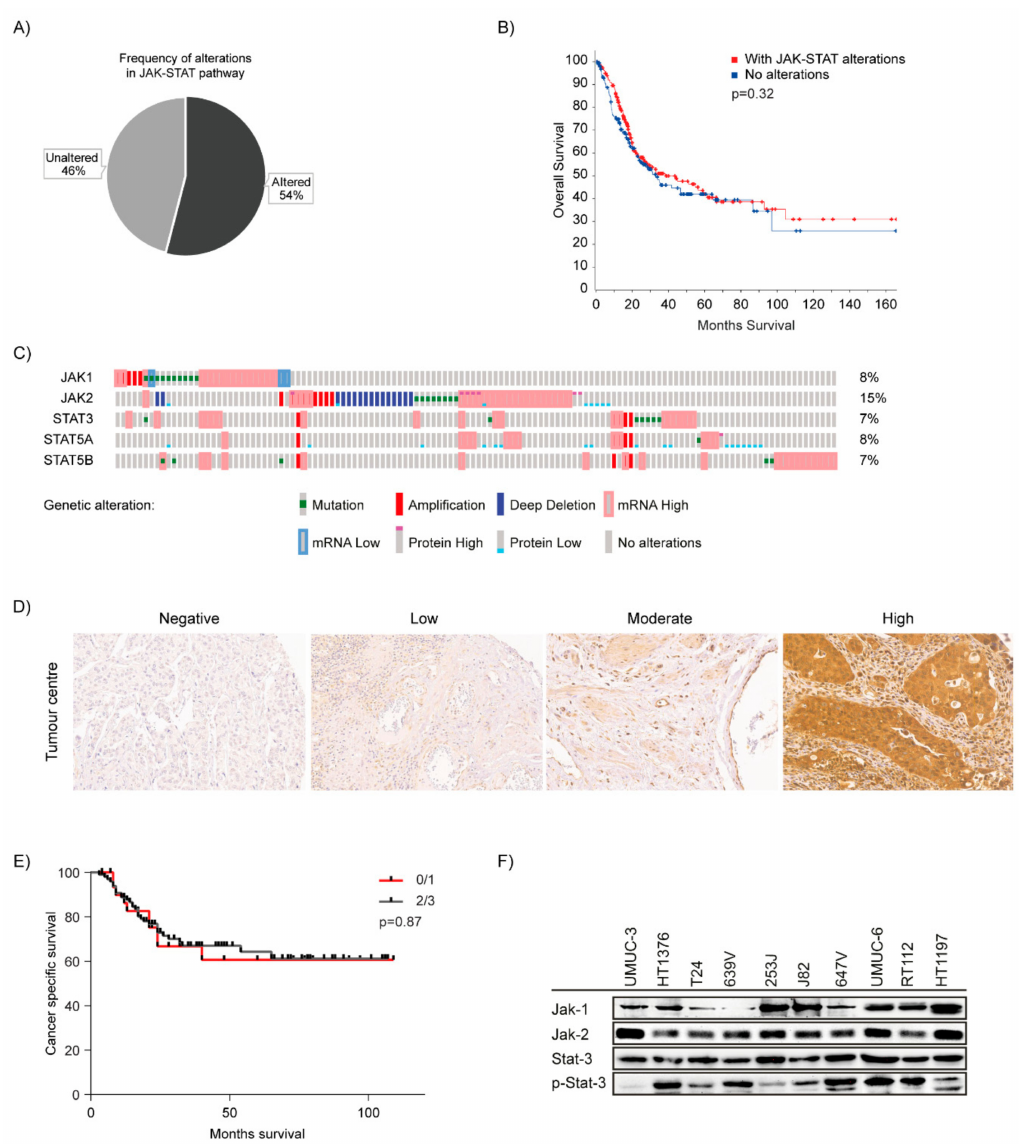
Figure 1. JAK-STAT pathway in bladder cancer: ( A ) TCGA cohort of 412 patients (413 samples) was analysed using cBioPortal. JAK-STAT pathway was altered in 54% of bladder cancer specimens. ( B ) Kalpan-Meier plot depicting overall survival analysis among patients with and without alterations in JAK-STAT pathway in the TCGA cohort. ( C ) Alterations in JAK1, JAK2, STAT3, STAT5A and STAT5B genes—OncoPrint indicates tumours altered with mutations (green bars), amplification (red bars), homozygous deletion (blue bars), high mRNA (red—outlined bars), mRNA low (blue-outlined bars), protein high (bars with red cap), protein low (blue-bottomed bars) and no alterations (grey bars). ( D ) Immunohistochemistry of patient tissues stained for STAT3- images showing staining intensities- Negative (Score-0), Low (Score-1), Moderate (Score-2), High (Score-3). Tissue sections were imaged at 200 × magnification. ( E ) Kaplan-Meier plots for cancer specific survival analysis among patients with no or low STAT3 staining vs. moderate / high STAT3 staining. ( F ) Cell lines were analysed for Jak1, Jak2, Stat3 expression and Stat3 phosphorylation by